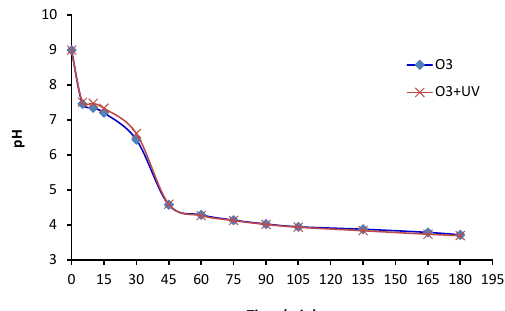
Fig. 5. Effect of ozone one different Direct Yellow 12 concentrations (100, 200, 300, 400 and 500 mg/l) versus time. (O = 500 mg/h, treated volume = 200ml, initial 3 solution pH 9).